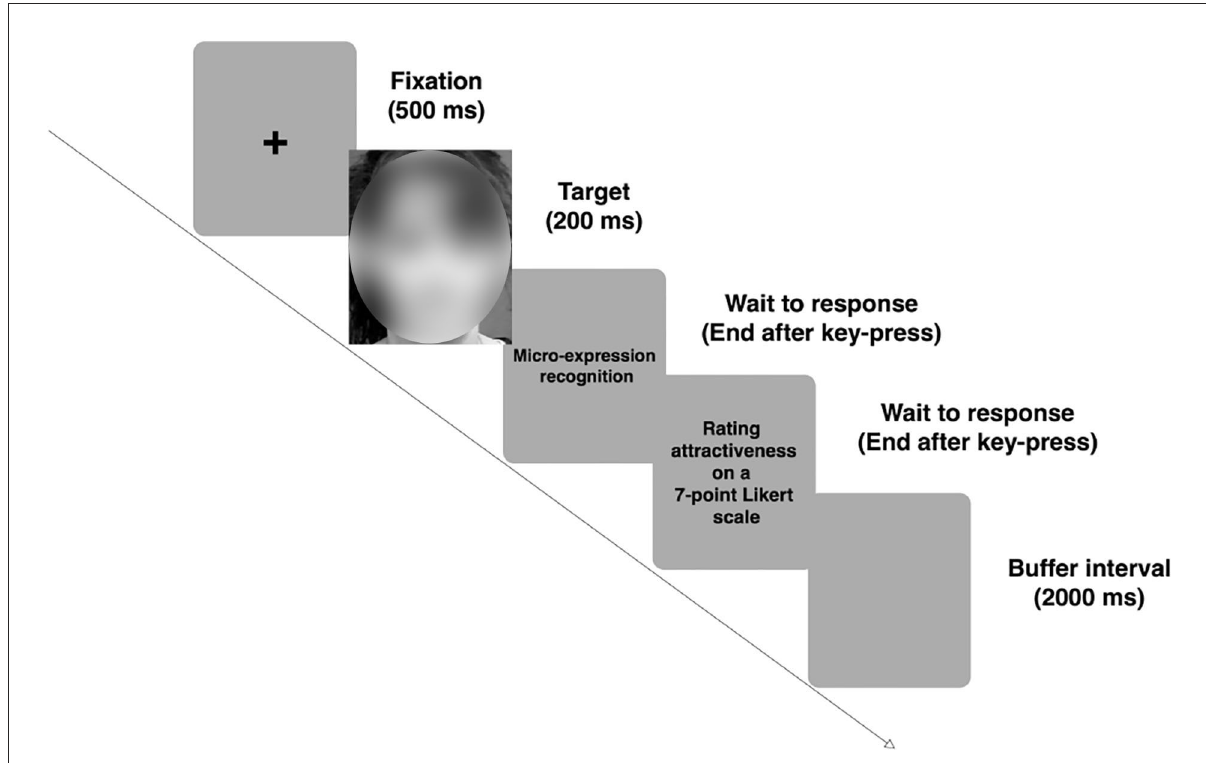
FIGURE1 The procedure of the micro-expression recognition task and 7-point Likert rating